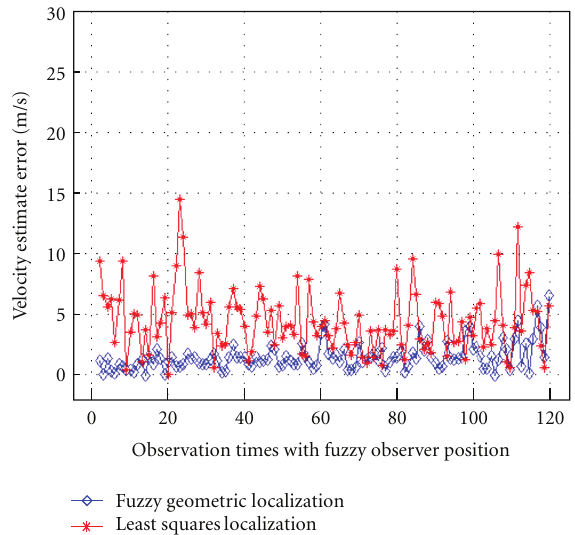
Figure 6: Velocity estimate error comparison with fuzzy observer